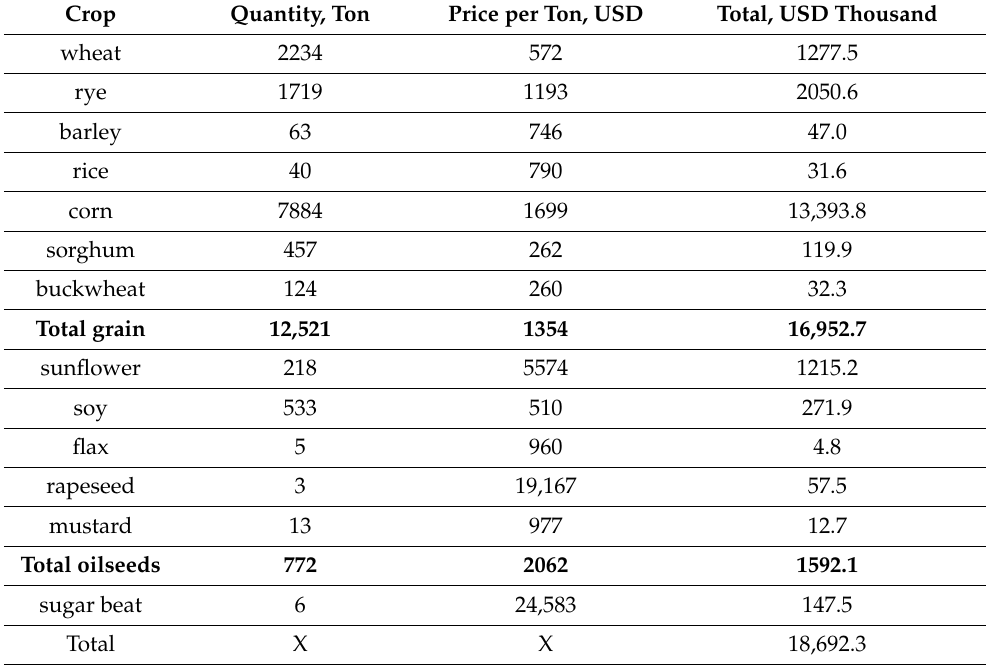
Table 1. Export of grain and oilseeds in